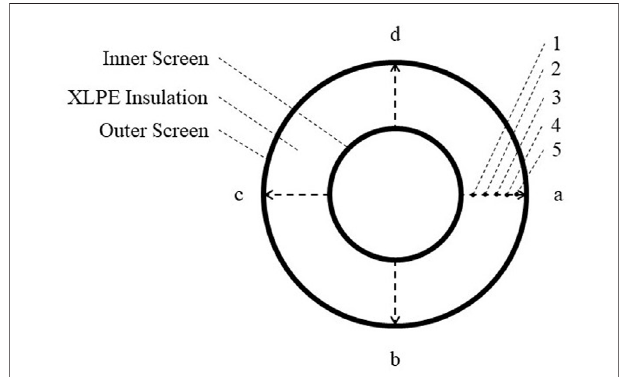
FIGURE 2 | Positions of measuring points on the XLPE